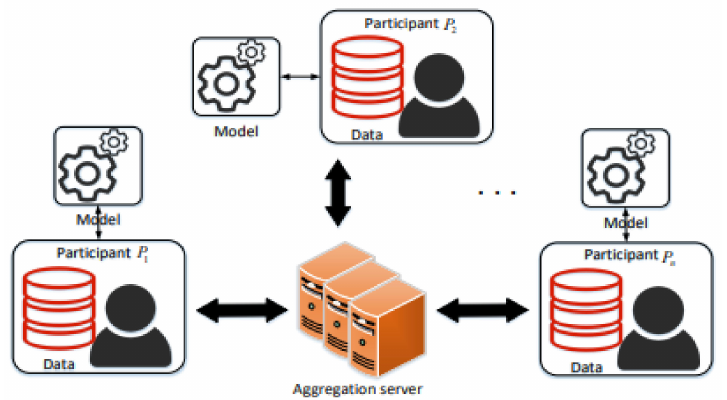
Figure 2. Federated learning framework proposed by Fu et